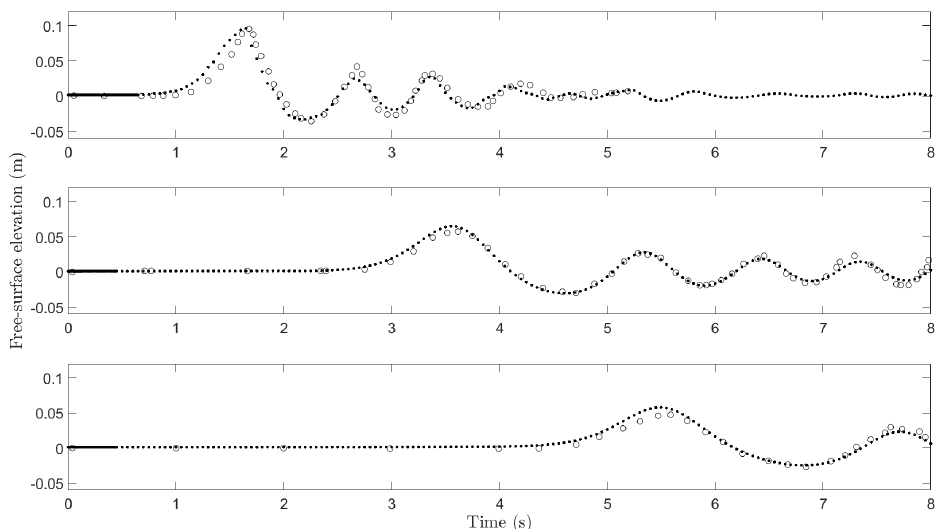
Figure 3. Model validation for subaerial landslide generated waves: records of free-surface elevation at fixed locations (Top to bottom: x = 4,8,12 m). Dot: model predictions. Circle: measurements reported by Heinrich